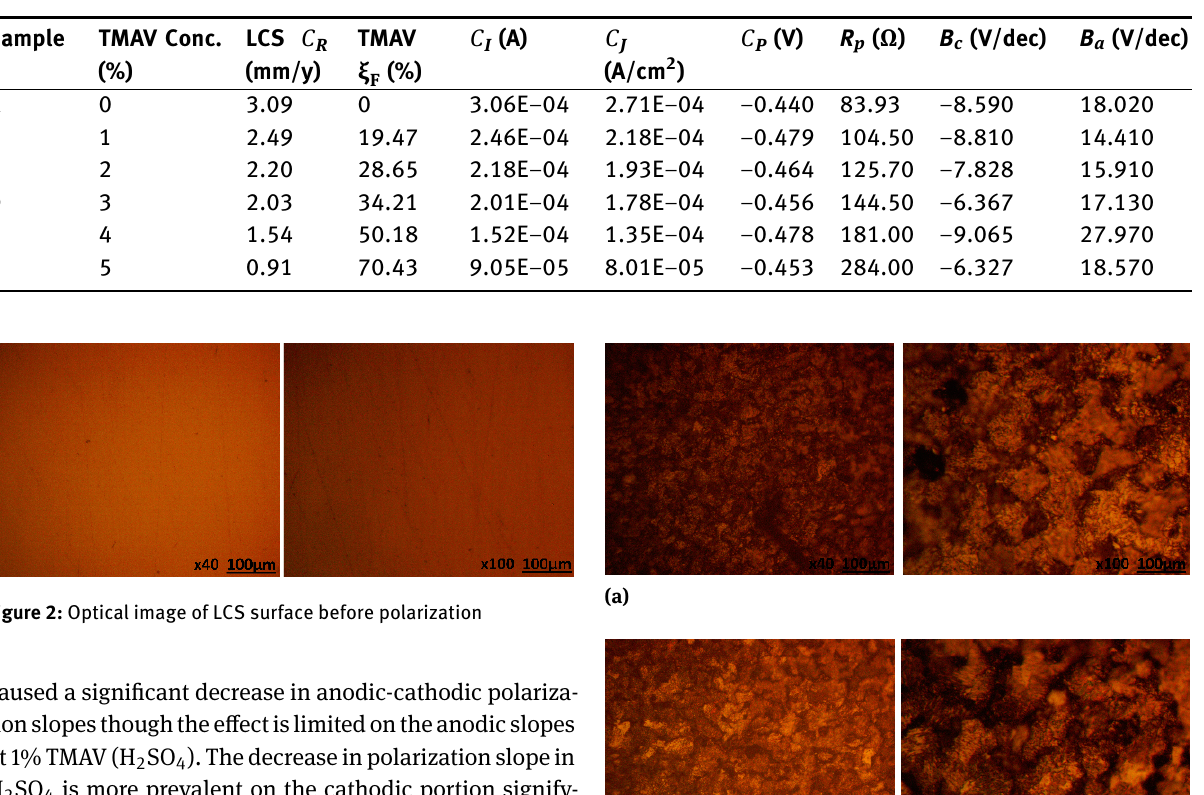
Table 3: Potentiodynamic polarization data for LCS corrosion in 1 M HCl at specific TMAV concentration